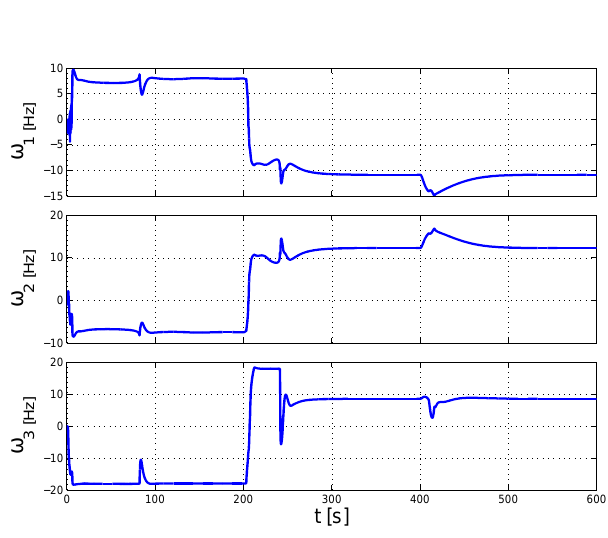
Figure 3: Actual propeller